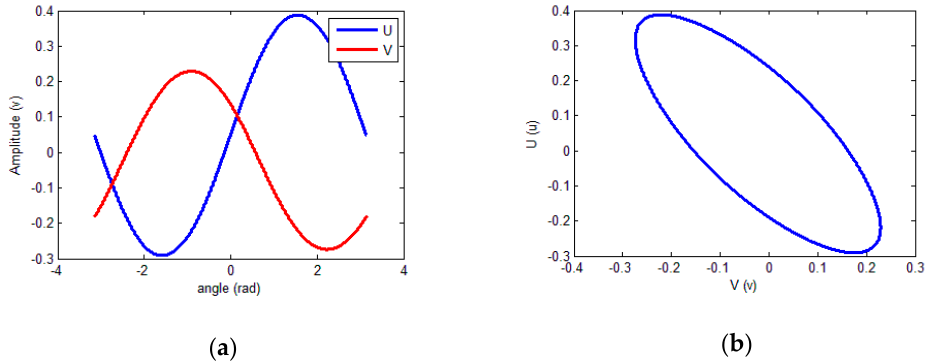
Figure 13. Signals for the simulation with harmonic components. ( a ) Amplitude versus input angle; ( b ) Lissajous figure for the simulation signals.